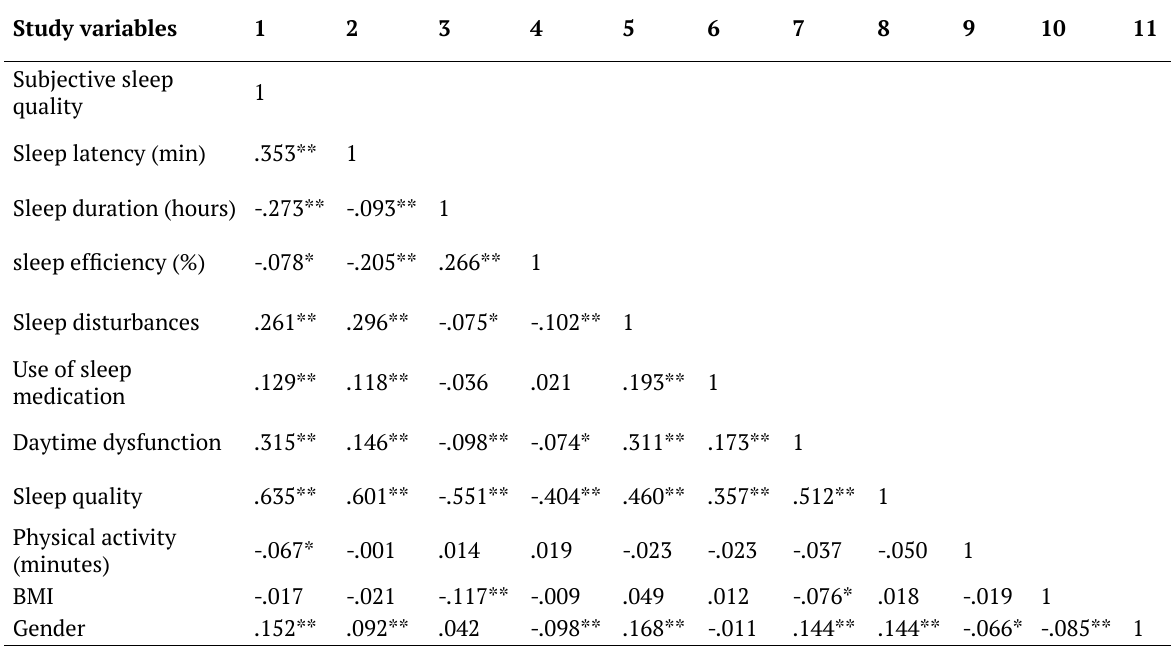
Table 4. Correlation coefficients between the study